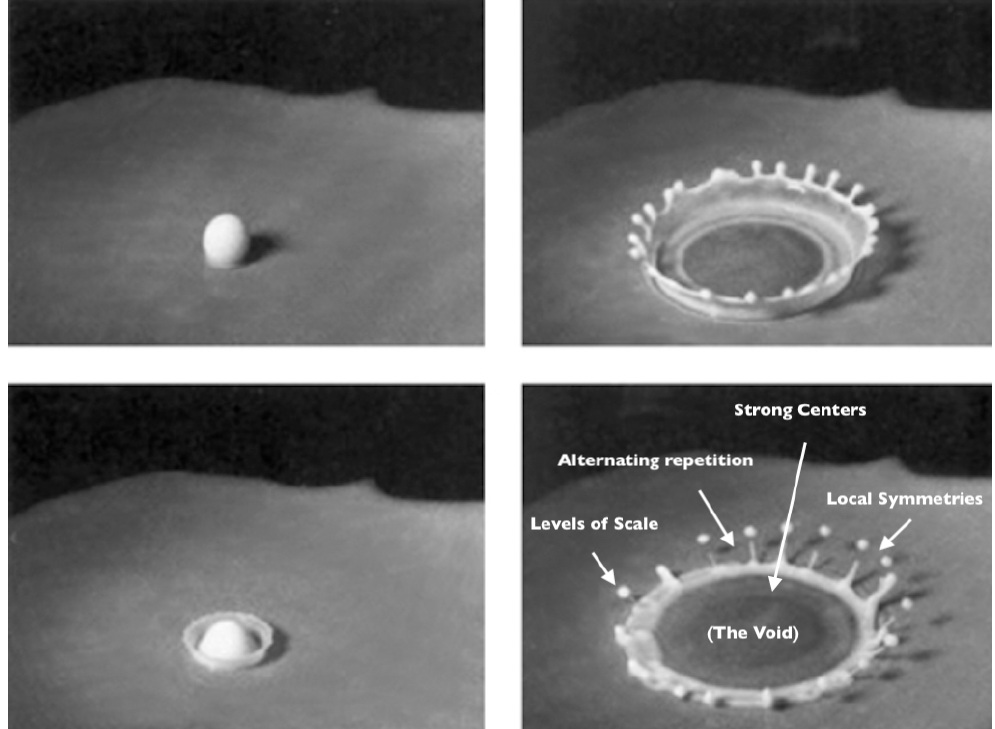
Figure 4. Alexander used this famous Harold Edgerton photo series of a milk drop to illustrate a “structure-preserving transformation,” in this case articulating new structures as the drop strikes a thin sheet of milk. This author has added labels identifying some of the characteristic geometric properties described by Alexander—strong centers, alternating repetition, boundaries, local symmetries and others. Alexander identified 15 categories to describe broad classes of these emergent properties, in nature and in human design. Original image © 2010 MIT. Courtesy of MIT